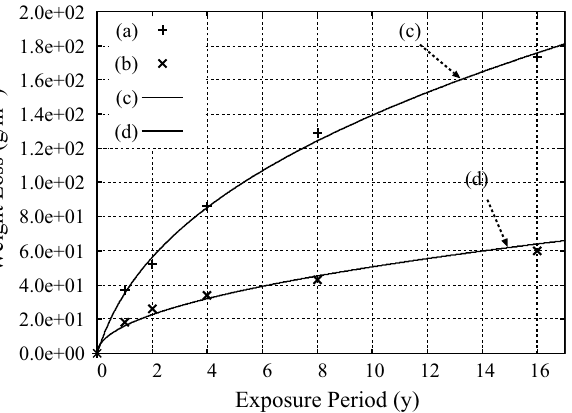
Figure 1. Corrosion of copper (99.9 % wt.) subject to ( a ) the marine atmosphere of PCZ at Cristobal, and ( b ) the inland atmosphere of PCZ at Miraflores after Southwell et al. 20 . Results of the calculations by using Eqs. (1) and (3) for simulating the corrosion of copper subject to the marine and inland atmospheres are shown in ( c ) 3.5 10 − 3 (mm) and A 0.547 , and ( d ) with B 1.6 10 − 3 (mm) and A 0 , respectively. with B = × = = × =